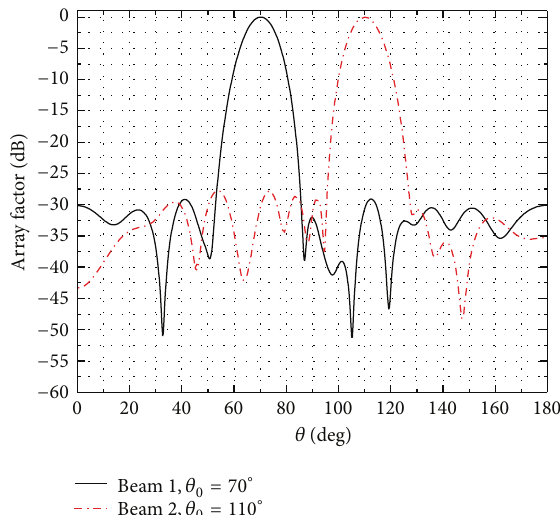
Figure 3: Radiation patterns of the two-beam configuration of C- BFN with a nonuniform linear array optimized by DE with beam steering in 70 ∘ and 110 ∘ .